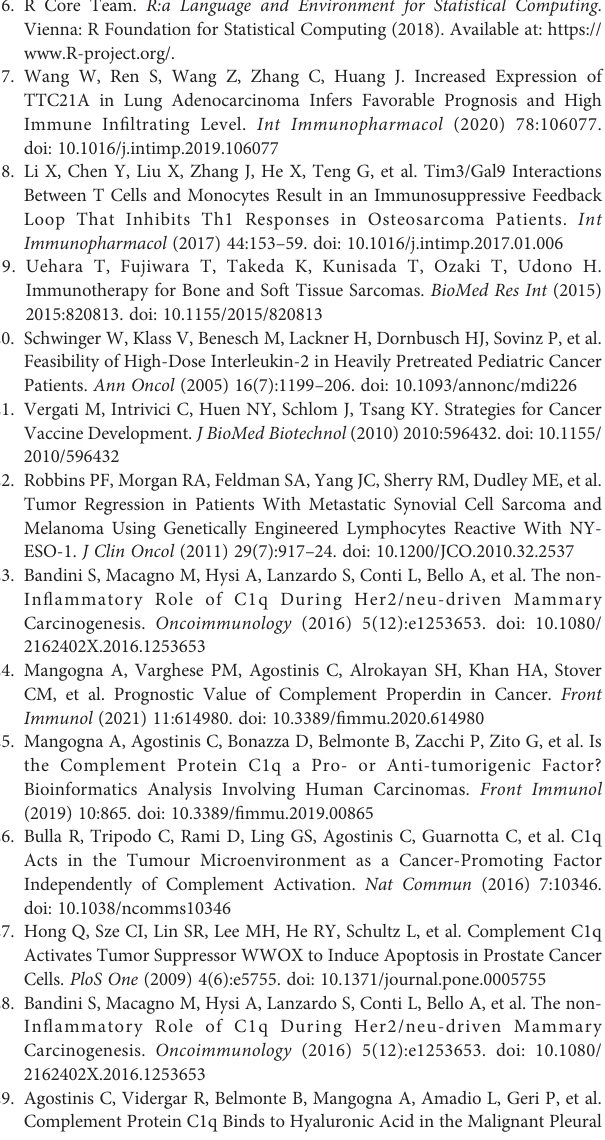
Supplementary Figure 1 | Relationships between CD163 expression and survival time in patients with OS. Supplementary Table 1 |